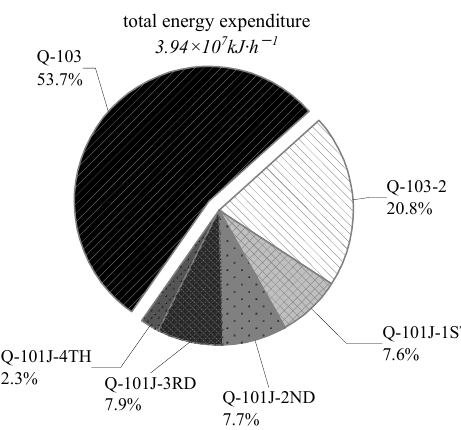
Figure 8. Energy consumption ratio of each unit.